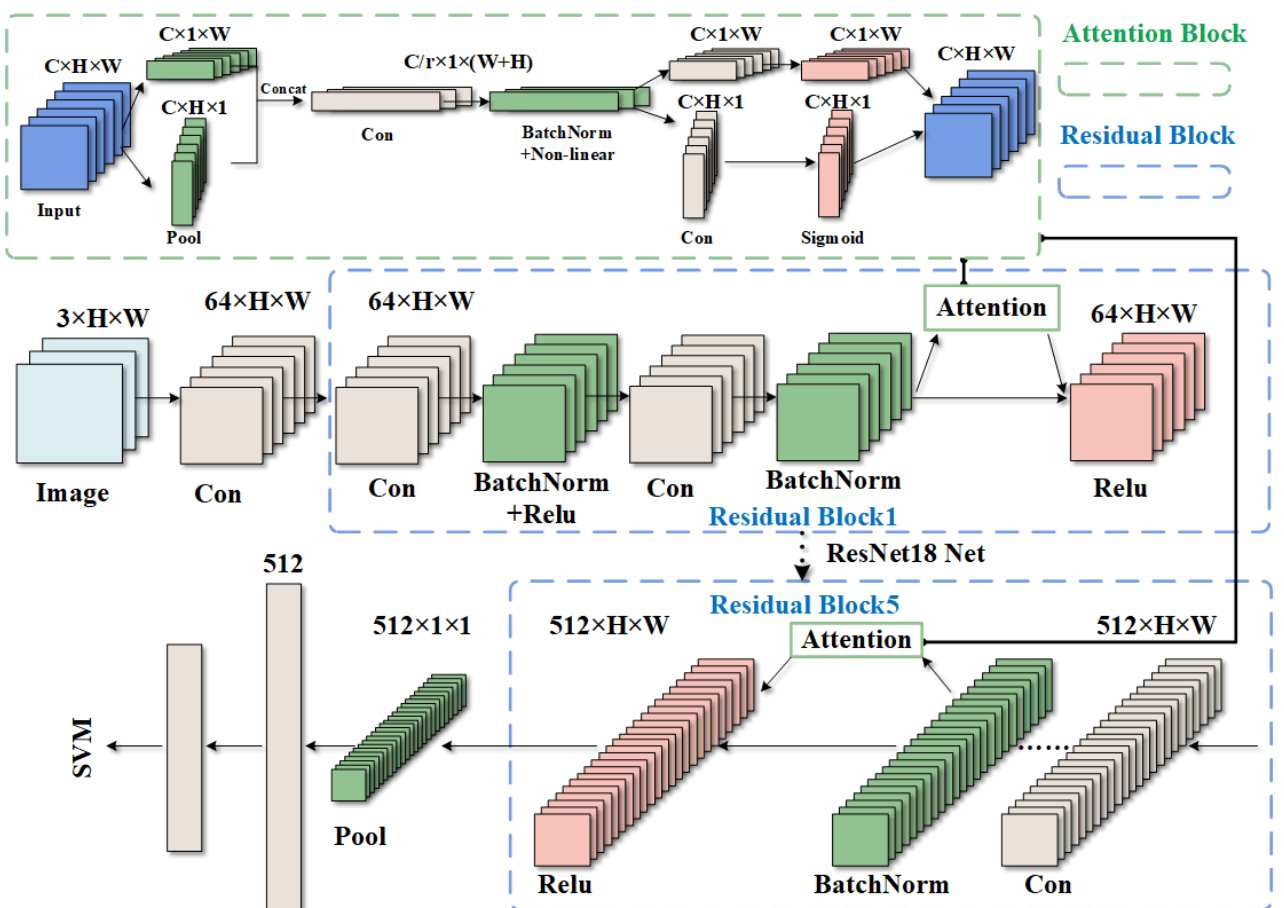
Figure 1. CASVM using ResNet18. Image goes through five residual blocks, with convolutional layer, attention block, and ReLU activation function. Attention block averages pooled data along two directions, reduces number of channels by a factor of r, and uses operations such as 1 × 1 convolution to obtain a number of channels equal to the input. Data go into SVM after final residuals for classification.